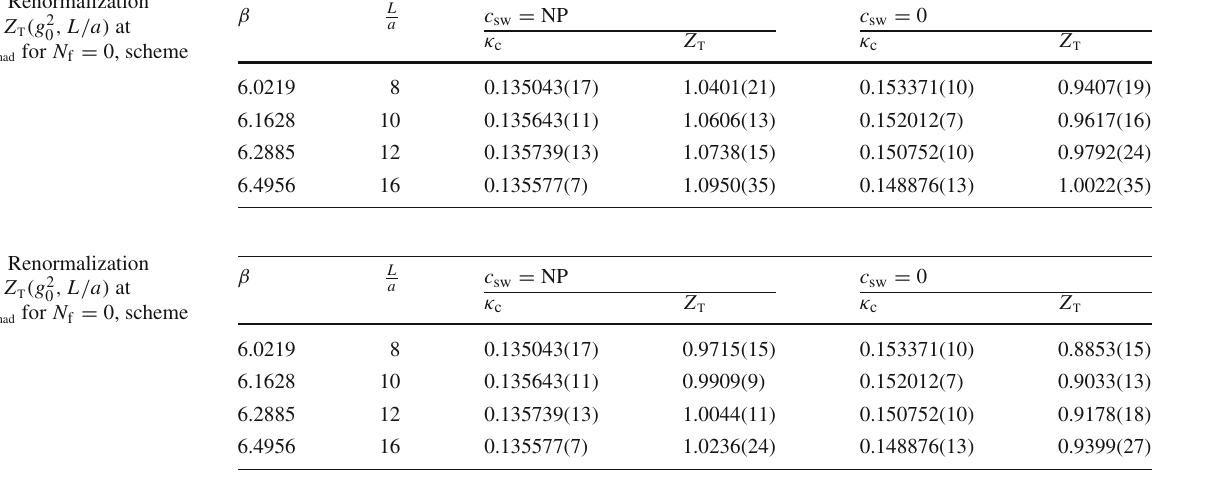
, L / a ) at 0 N f = 0, scheme had for